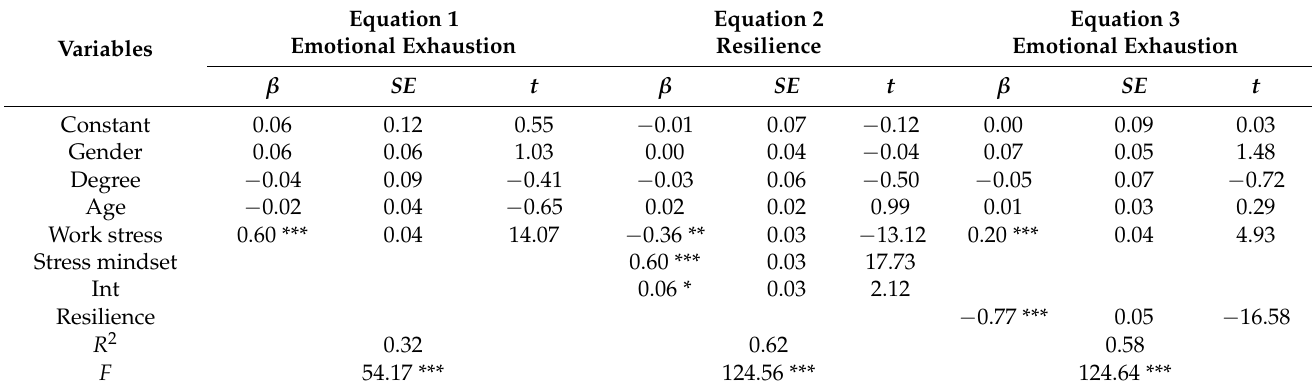
Table 2. Moderated mediating effect of work stress on emotional exhaustion ( N = 456).